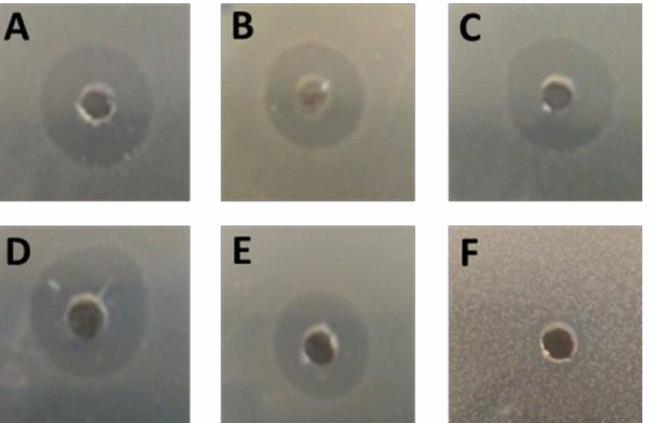
Figure 1. Inhibition of Lactococcus garvieae growth by GarKS cultured overnight on Mueller–Hinton agar plates at 30 ◦ C. Note the inhibition zones around L. garvieae strain ( A ) b. baraja, ( B ) lg, ( C ) perbe- mbe, ( D ) cp-1, and ( E ) Ba063090, all from infected fish. Additionally, note the absence of inhibition zone around strain KS2546 ( F ) which is the bacteriocin producer itself. For all L. garvieae strains, 100 µ L of 10 7 CFU/mL bacterial suspension were spread on Mueller–Hinton agar plate, while 50 µ L of 33 µ g/mL GarKS were put in the well at the centre of each